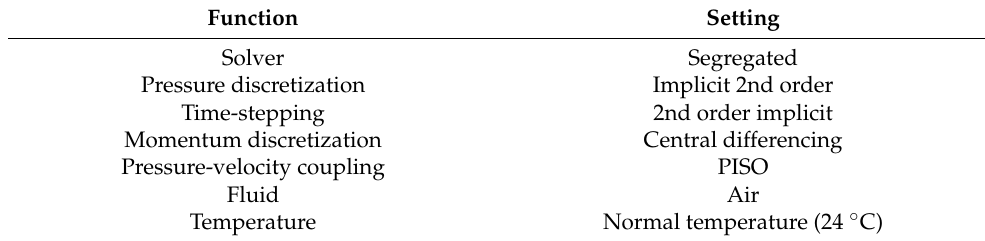
Table 2. Boundary Conditions settings.